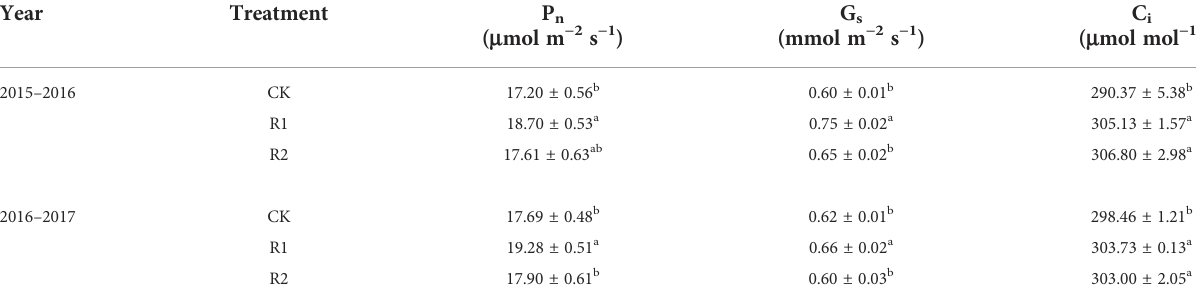
TABLE 4 Leaf photosynthetic parameters of different treatments at the fl owering stage in two years. Year